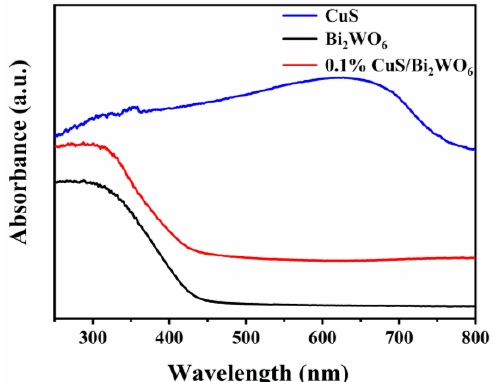
Figure 9. UV-Vis DRS spectrum of Bi 2 WO 6 , CuS, and 0.1% CuS/Bi 2 WO 6 heterostructure.